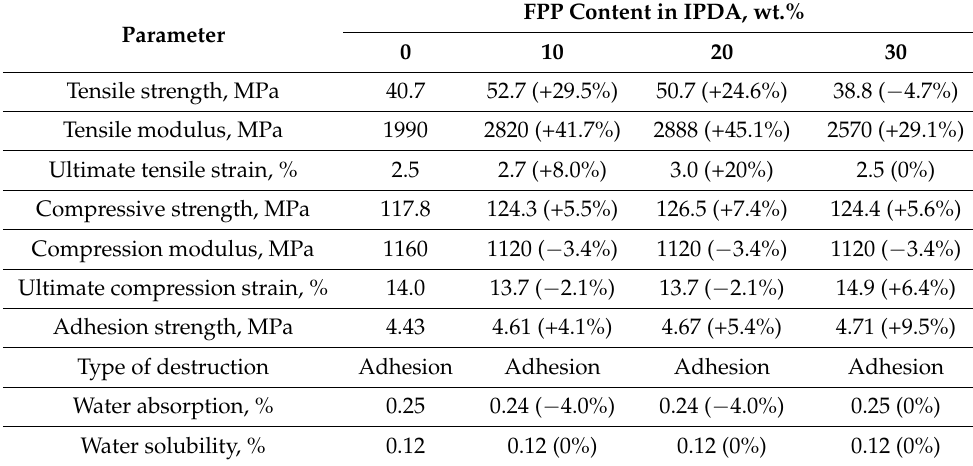
Table 5. Dependence of the mechanical and physicochemical characteristics of the studied composi- tions on the modifier content in the hardener (relative change with respect relative to the modifier-free samples is shown in